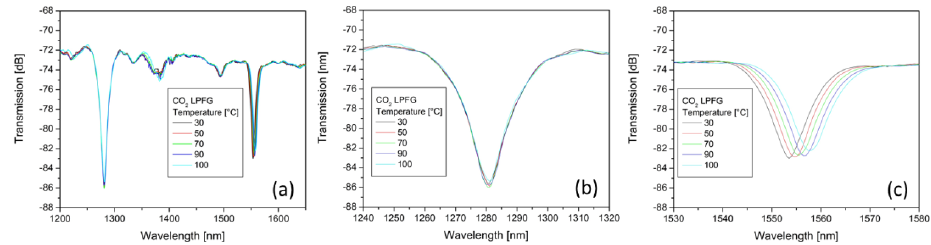
Figure 5. The transmission spectrum of ( a ) multiplexed LPFGs, ( b ) MI-LPFG, ( c ) CO 2 LPFG versus applied temperature on the CO 2 LPFG.